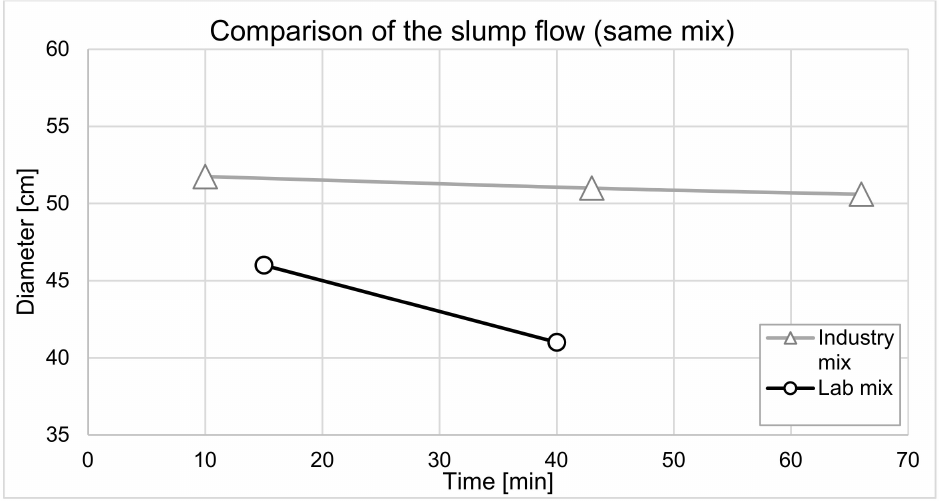
Figure 1. Comparison of the slump flow evolution of a given concrete having the same mix design produced in the industrial and academic laboratory,